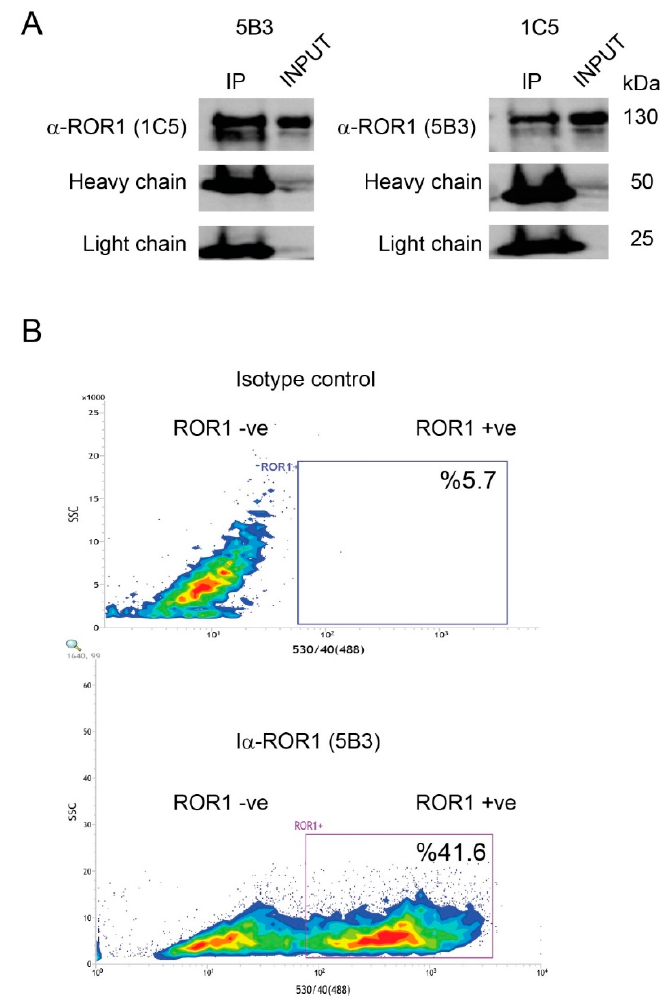
Figure A1. ROR1 monoclonal antibodies detect native and denatured forms of ROR1. ( A ) ROR1 protein was immunoprecipitated by ROR1 monoclonal antibodies 1C5 and 5B3. The immunoprecipitate of 5B3 was probed with 1C5, and that of 1C5 was probed with 5B3 antibodies in a Western blot. Heavy and light chains of the antibodies were used as IP control. ( B ) ROR1 expression in PLC/PRF/5 cells was assessed in flow cytometry by using 5B3 antibody. The isotype staining and ROR1-specific detection are shown in upper and lower panels, respectively. Alexa488-anti-mouse IgG antibody was used as a secondary antibody.